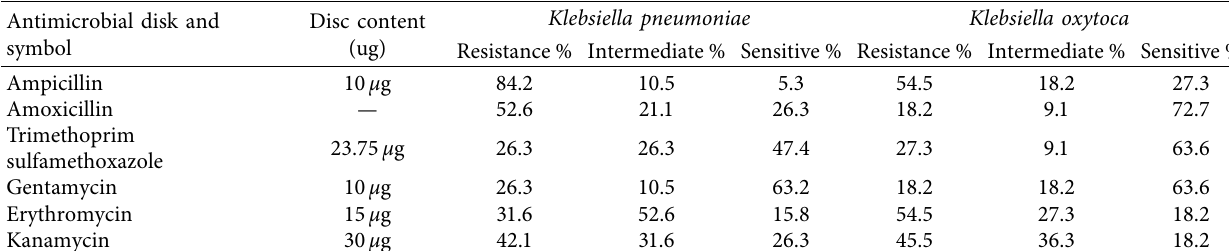
Table 2: Antibiotic susceptibility testing of Klebsiella species from the gut of bees. Antimicrobial disk